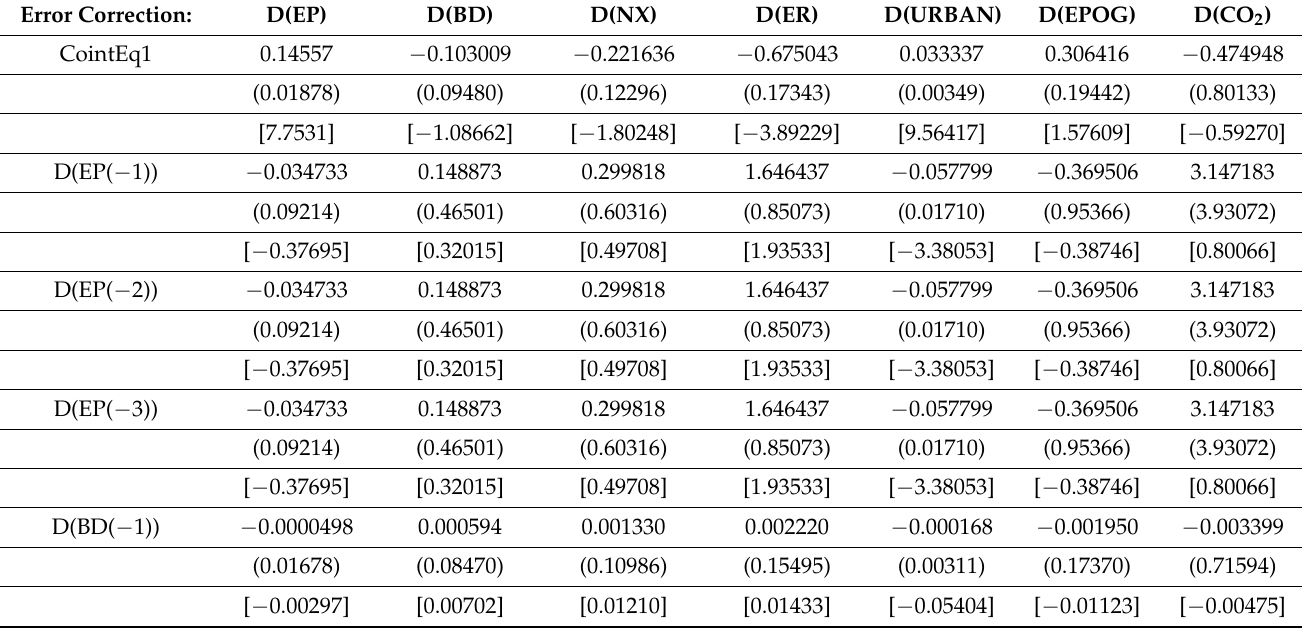
Table A1. Vector error correction short-run